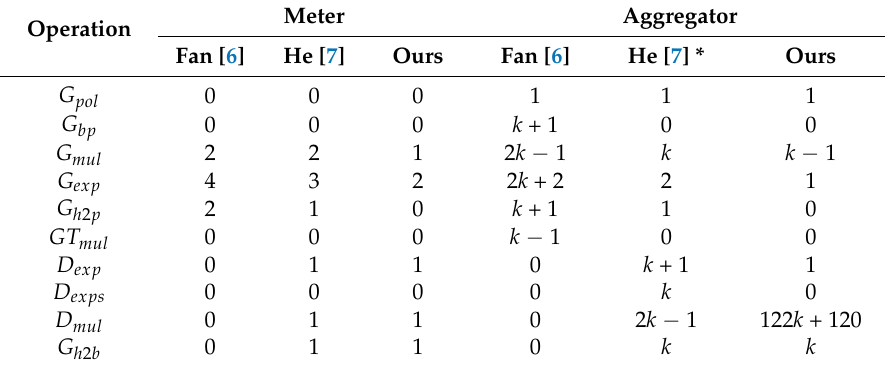
Table 9. Computation cost of the registration phase.